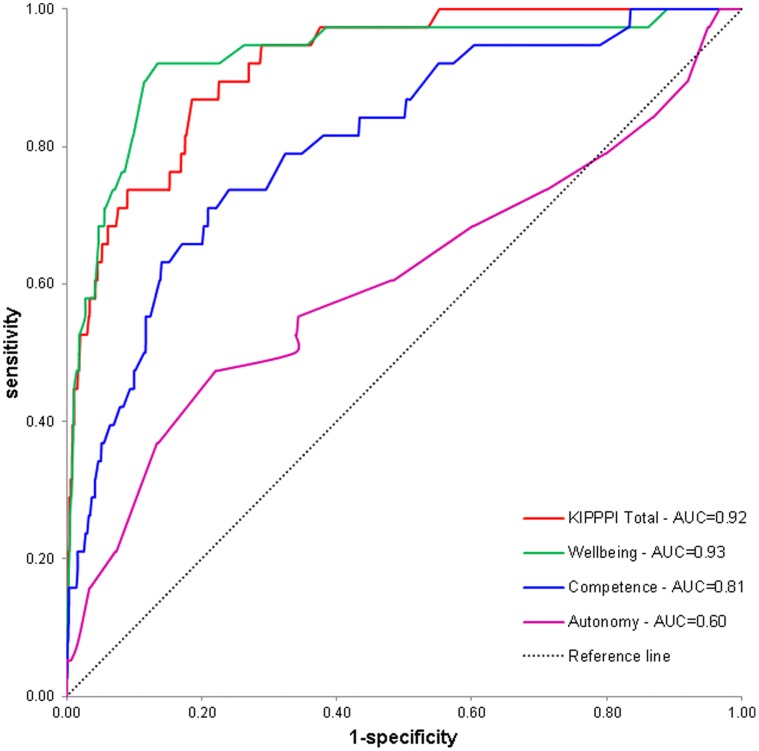
KIPPPI Receiver Operating Characteristic (ROC) curve.Receiver Operating Characteristic curve for KIPPPI scales Wellbeing, Competence, Autonomy and KIPPPI Total score, relative to CBCL1.5-5 Total Problem score in the clinical range. AUC = area under the curve.